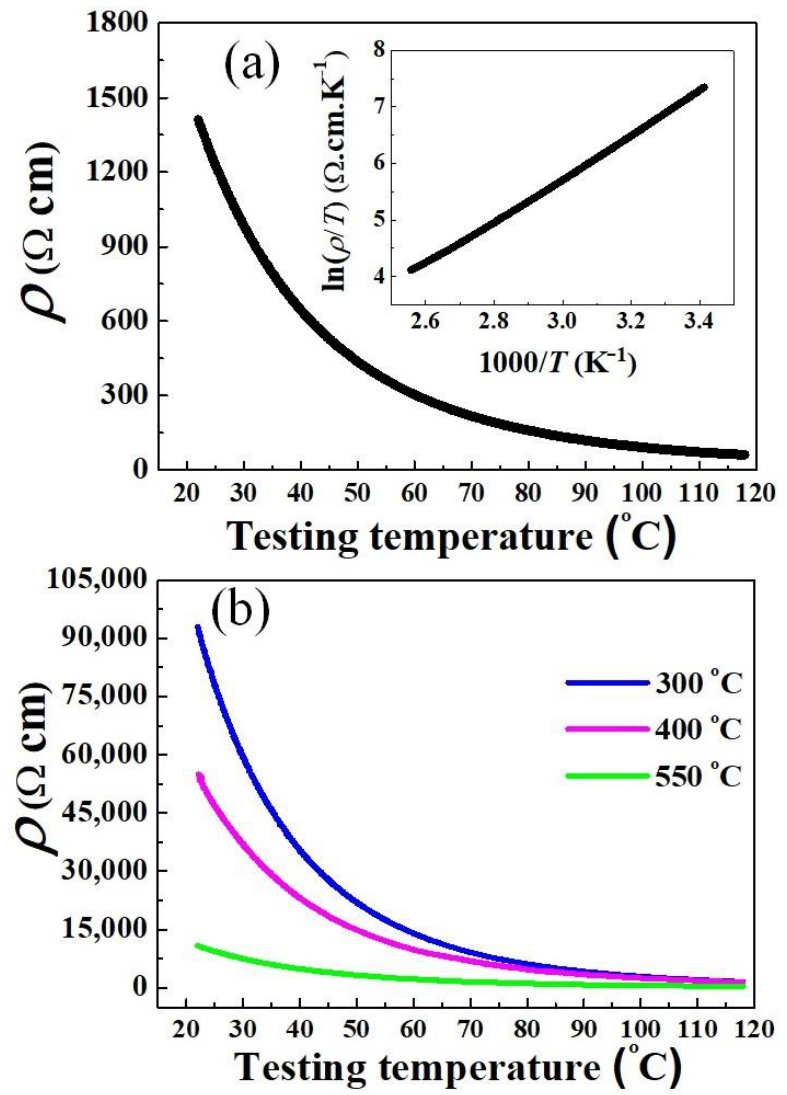
Figure 9. Resistivity–temperature ( ρ – T ) dependence of sintered ceramics (1100 ◦ C, 2 h), produced from powders calcined at ( a ) 650 ◦ C, and ( b ) lower than 650 ◦ C. The insert in ( a ) shows the plot of ln( ρ / T ) versus (1000/ T The drift in resistance ( R / R ) due to aging and/or long time operation, the so-called aging coefficient, is also vital for practical applications. The R / R describes the electrical stability, and it should be as low as possible to maintain external responses [38]. Table 3